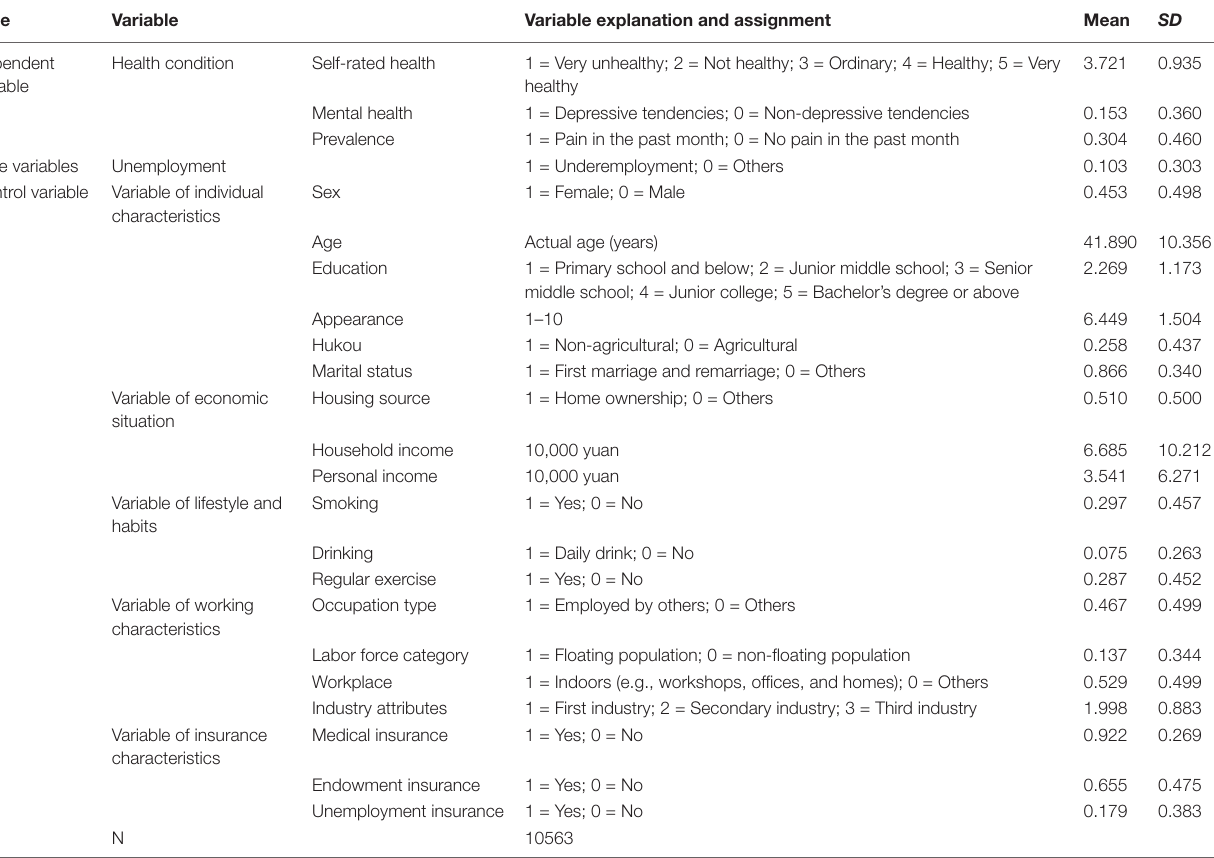
TABLE 1 | Descriptives and correlations among the study variables.